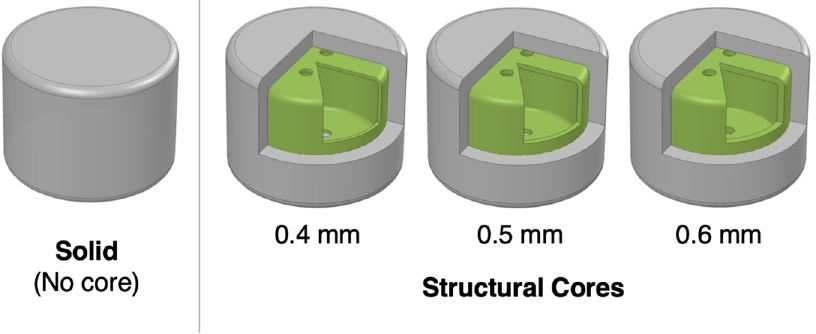
Fig 7. Structural core specimens. The four types of strutural core silicone specimens tested. The solid specimen has homogeneous material throughout its volume. The cores in the other specimens have a thickness of 0.4 mm, 0.5 mm, and 0.6